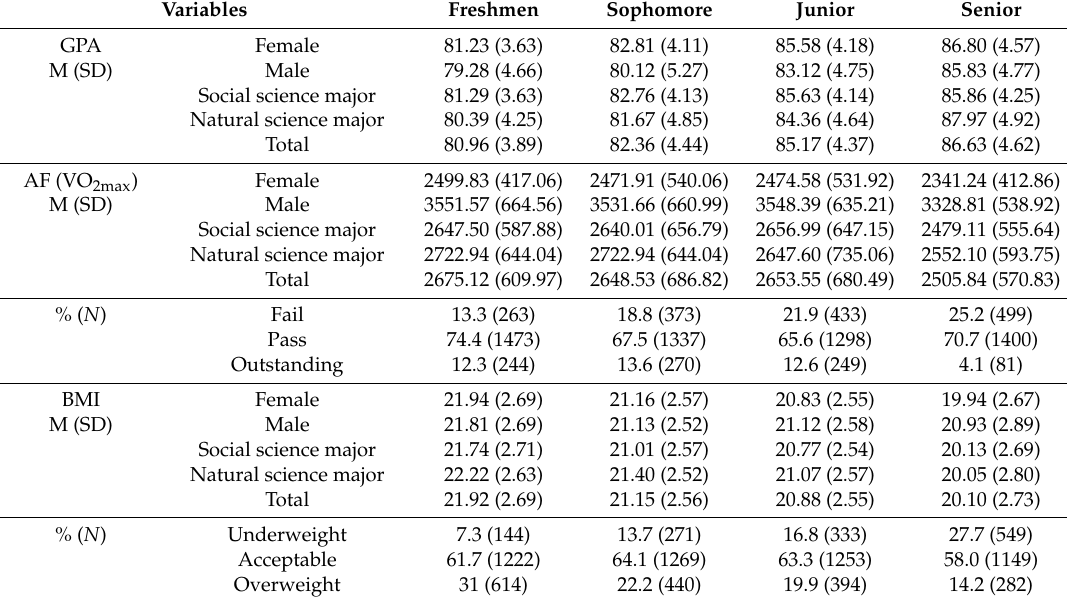
Table 1. Descriptive Statistics of Grad Point Average (GPA), Aerobic Fitness (AF), Body Mass Index (BMI) by Gender, Year in College, and